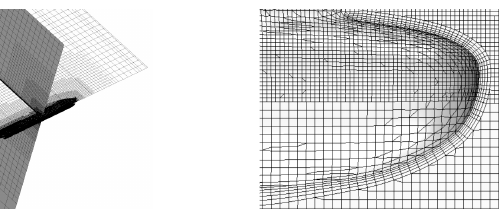
Figure 9. The KCS mesh. Figure 9. The KCS